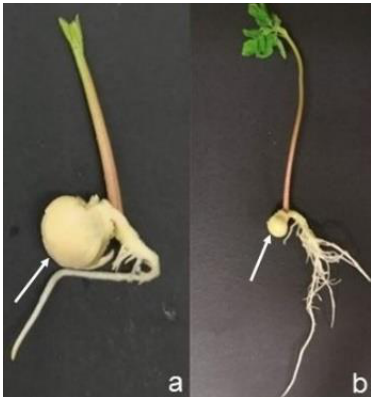
Figure 6. Analyzed Moringa sprout and cotyledon (arrows) developmental stages: ( a ) sprout with the first true leaves (Stage 1); ( b ) sprout with four leaves (Stage 2).